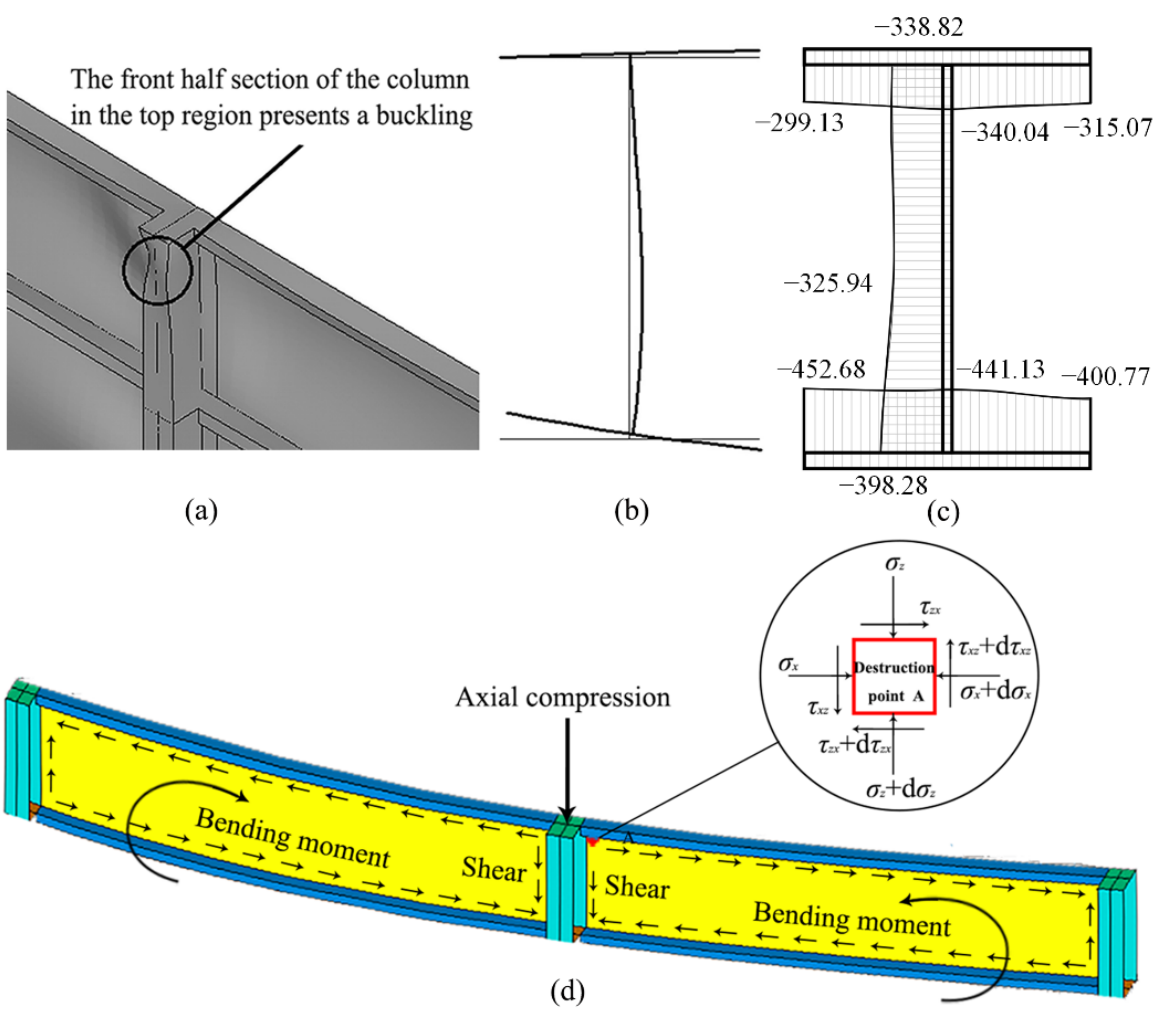
Figure 5. Column buckling modes (model M4): ( a ) Buckling mode in top region of column (460 MPa steel), ( b ) Deformed column section (460 MPa steel), ( c ) Axial stress distribution of the column when reaching the ultimate load (460 MPa steel), ( d ) Loaded condition of the top panel of wallboard.